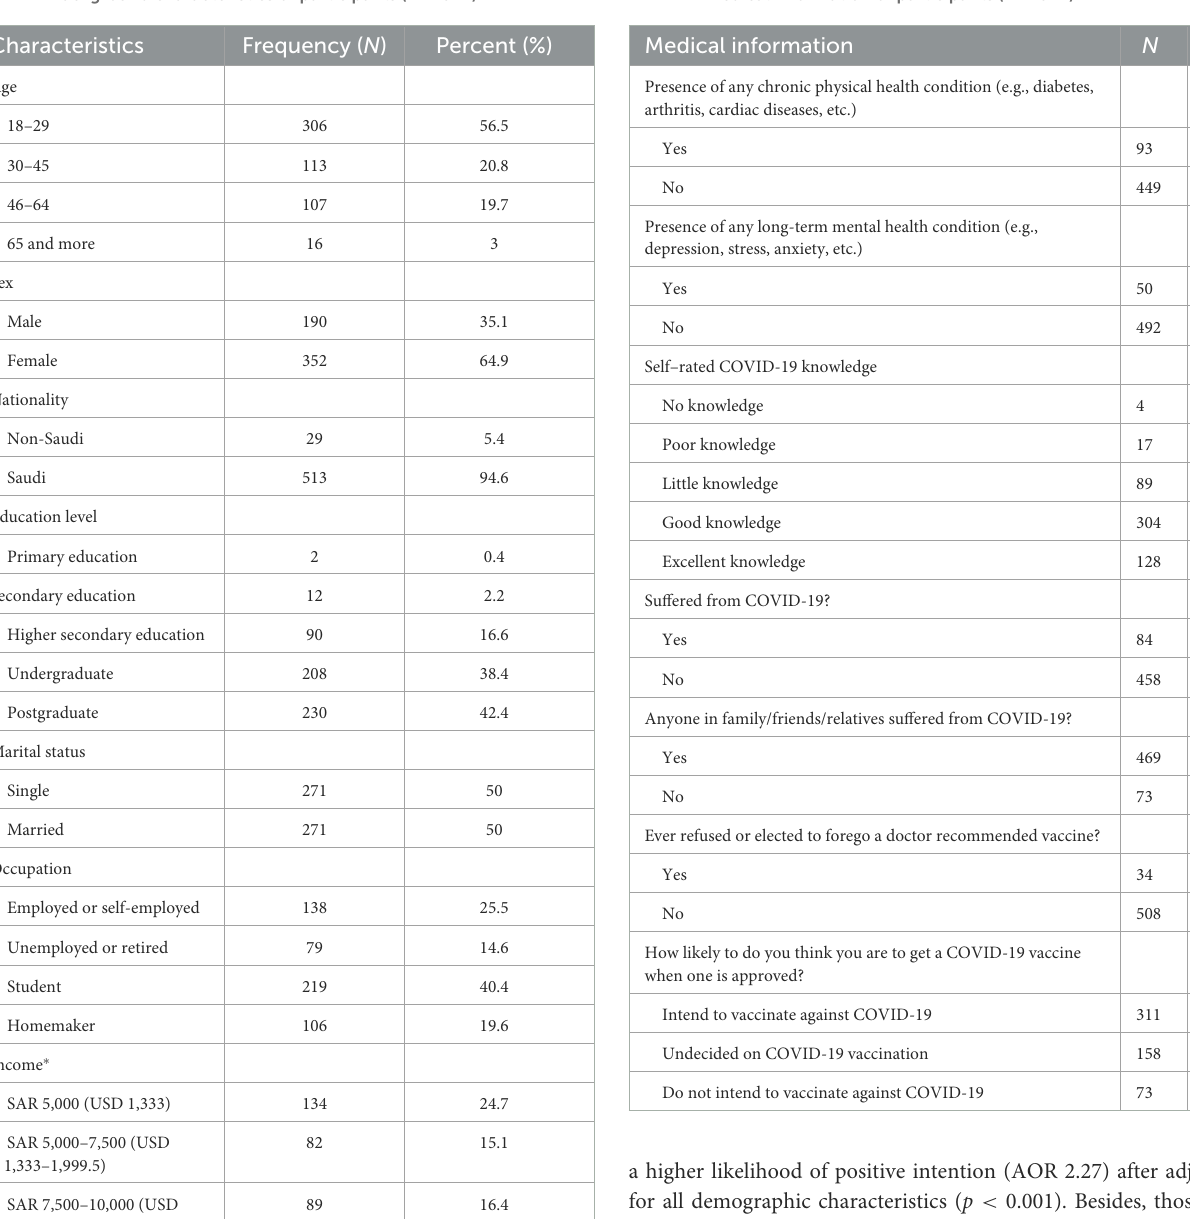
TABLE 1 Background characteristics of participants ( N = 542). TABLE 2 Medical information of participants ( N =